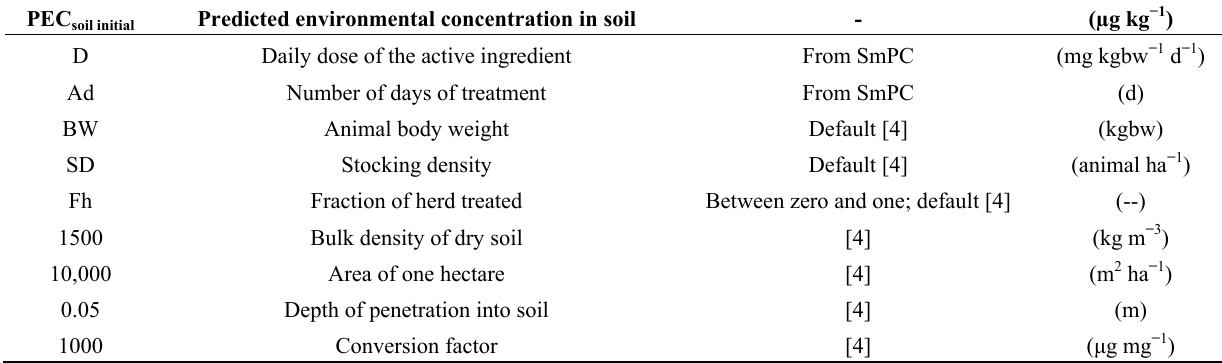
(equation 1). soil initial